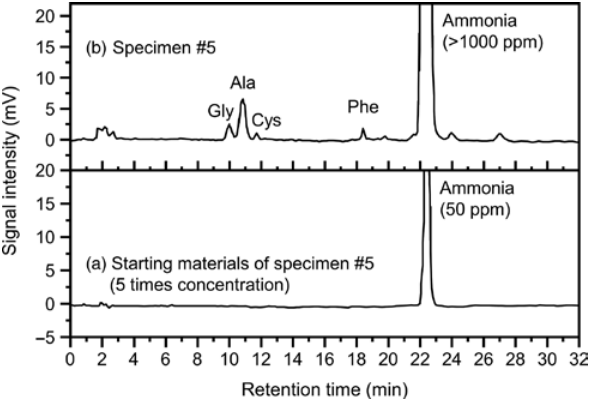
Figure 5: Analysis of amino acids in specimen 5 and its starting